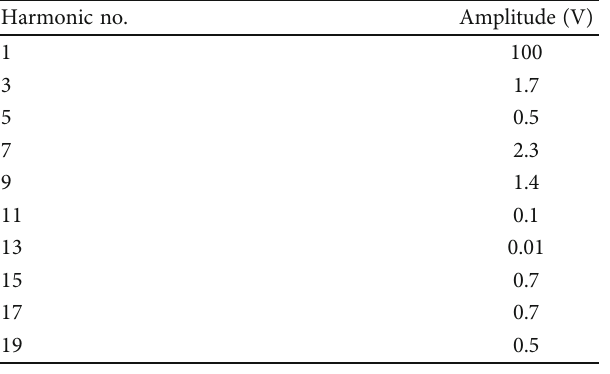
Table 5: Harmonic vs. amplitude. Harmonic no.